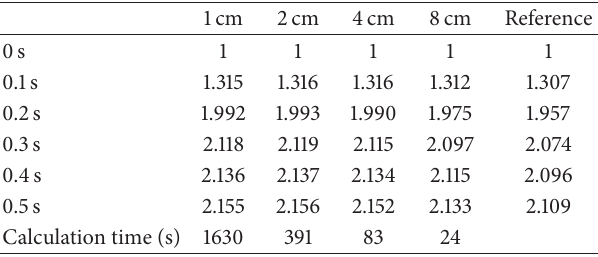
Table 10: Normalized power versus time with and without flux estimation in TWIGL problem during ramp perturbation.